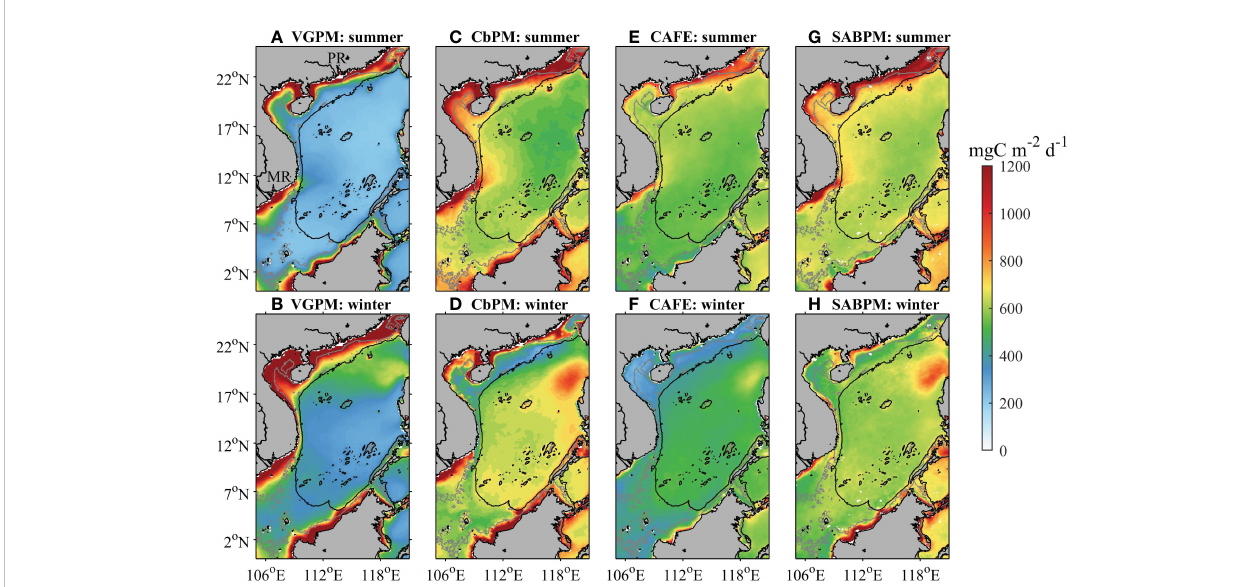
FIGURE 1 Climatological ocean NPP in summer and winter during 2002 – 2020 in the study area produced using four algorithms: (A, B) VGPM, (C, D) CbPM, (E, F) CAFE, and (G, H) SABPM. The grey lines are the 50 m isobaths and the black lines are the 200 m isobaths. The location of the Pearl River (PR) and the Mekong River (MR) is indicated in (A) .